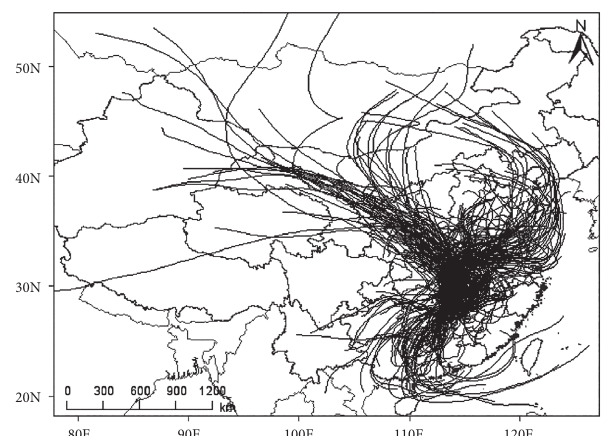
Figure 1: Distribution of backward airflow trajectories from December 2019 to February 2020 in Chang-Zhu-Tan region.